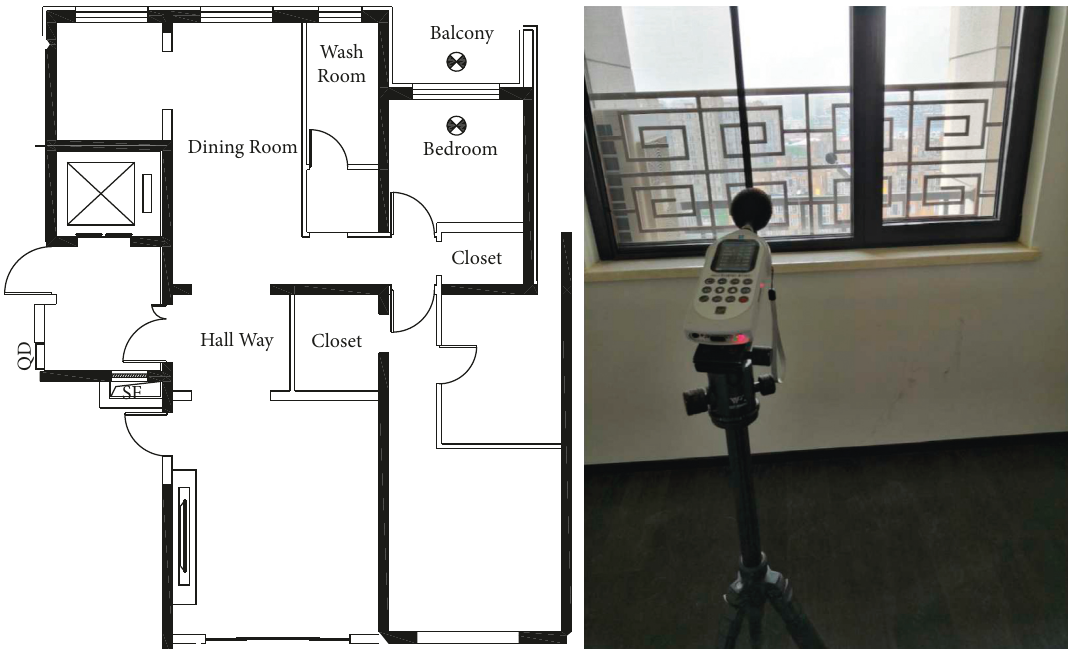
Figure 3: The location and view of measurement points for MR1 and